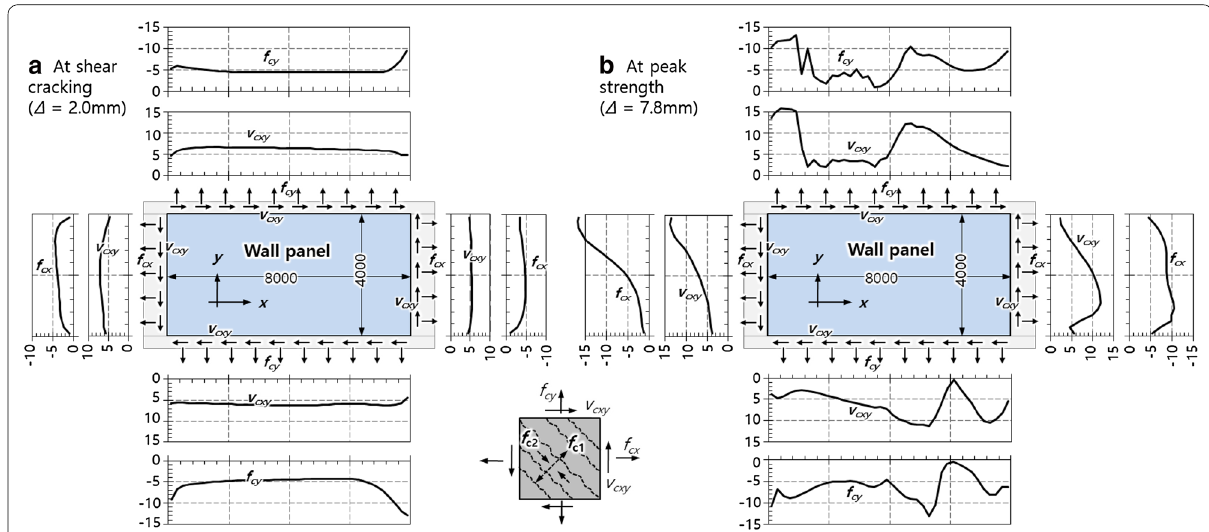
Fig. 16 Distributions of concrete stresses along the boundaries of belt wall panel